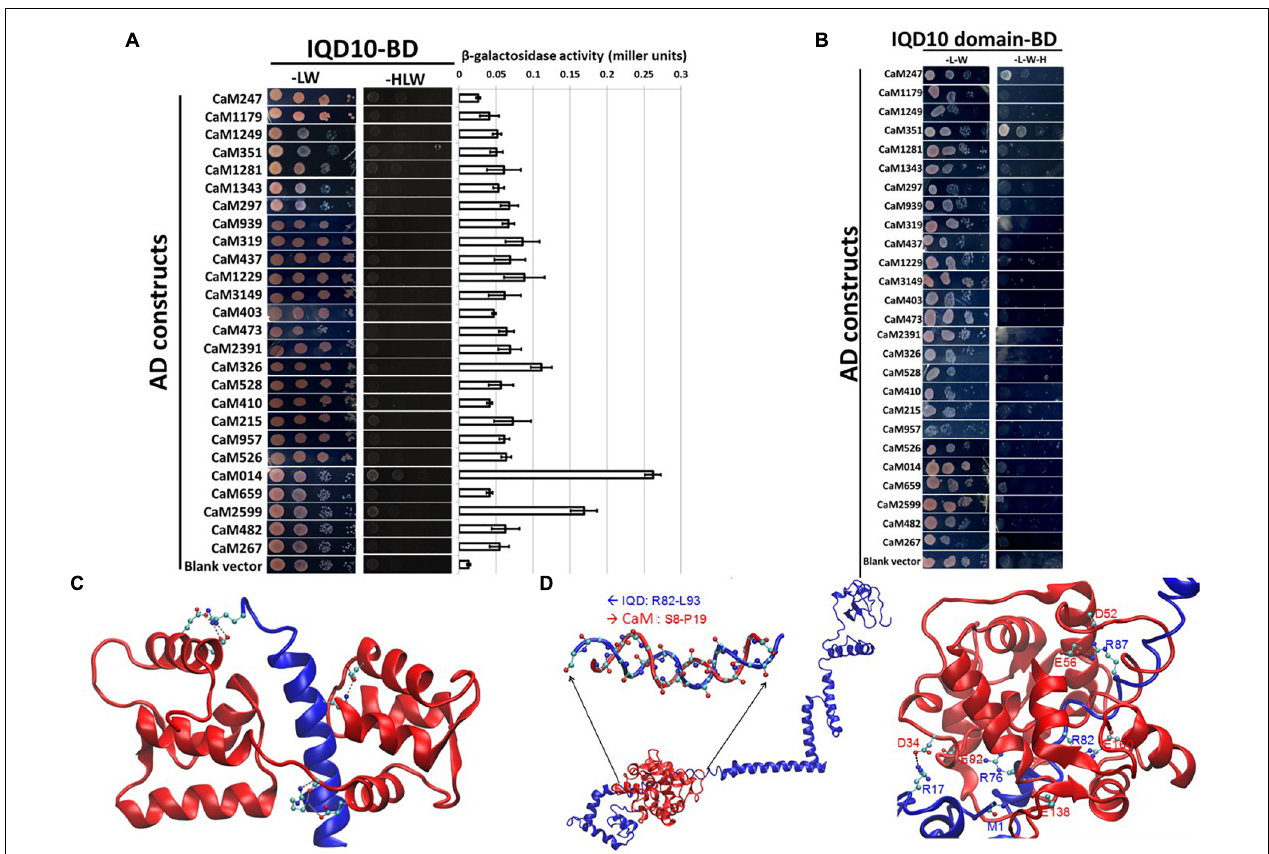
FIGURE 3 | Yeast two-hybrid interaction analysis of PdIQD10 with CaMs. (A) Yeast two-hybrid interaction analysis of full-length PdIQD10 with 26 calmodulins encoded by Populus genome. This figure shows the positive interaction of PdIQD10 with CaM014 and CaM2599. Bar graph on the right represents the average β -galactosidase activities assayed from three independent yeast colonies to determine the strength of the interactions. (B) Yeast two-hybrid interaction analysis of IQ67-domain of PdIQD10 with different calmodulins. The IQ67-domain only version of PdIQD10 interacts with CaM247 and CaM351 but not with CaM014 and CaM2599 indicating the difference in functionalities and specificities between full-length PdIQD10 and IQ-67 domain only version. (C) A cartoon representation of MD simulation showing IQD-domain only and CaM247 protein interactions. The flip-and-flop of Calmodulin (CaM, in Red) around the IQD domain (in Blue) makes many of the interactions between the two molecules transient. Strong electrostatic interactions (i.e., salt bridges) persist. (D) A cartoon representation of the complex of full-length IQD (blue) and CaM014 (red); (left) the inset shows a hybrid duplex between R82 to L93 of IQD and S8 to P19 of CaM mainly formed by dipole-dipole interactions between the backbone of the regions of both proteins; (right) Salt-bridge interactions between the basic residues (Arg and the backbone of N-terminus) of IQD and acidic residues (Asg and Glu) of CaM with basic